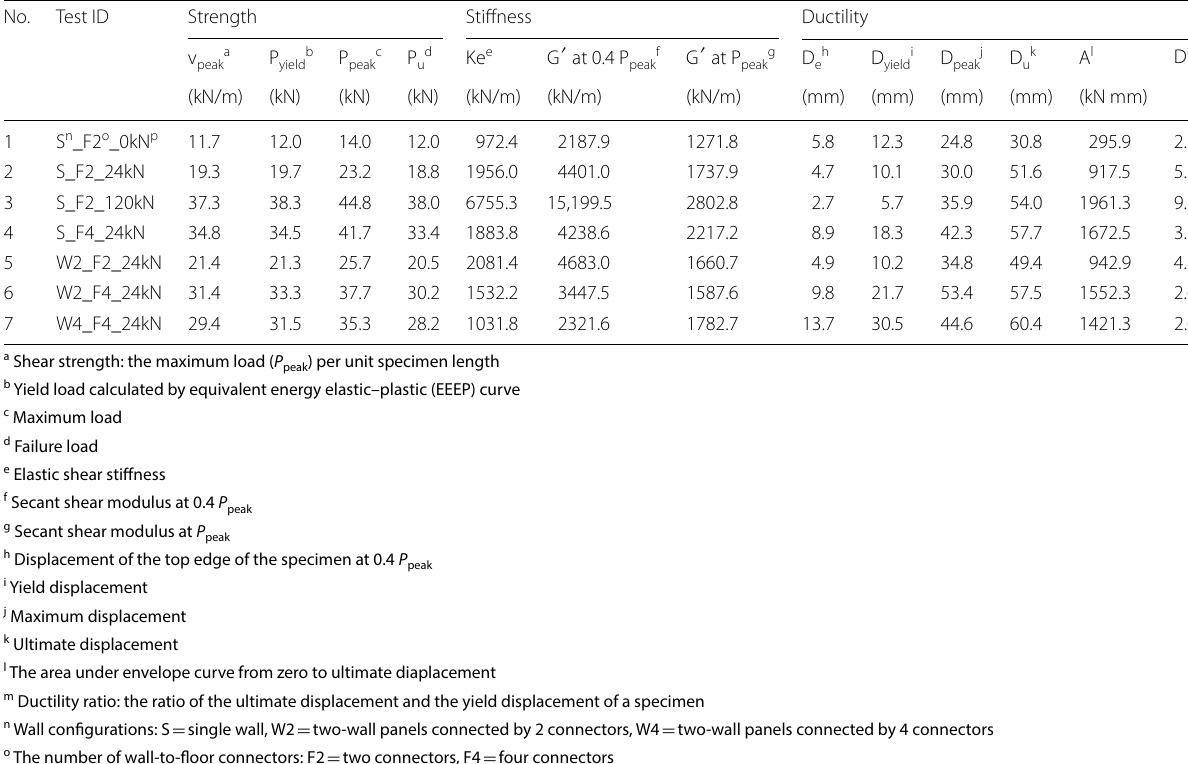
Table 2 Mechanical properties of tested Ply‑lam shear wall according to CUREE load protocol in ASTM